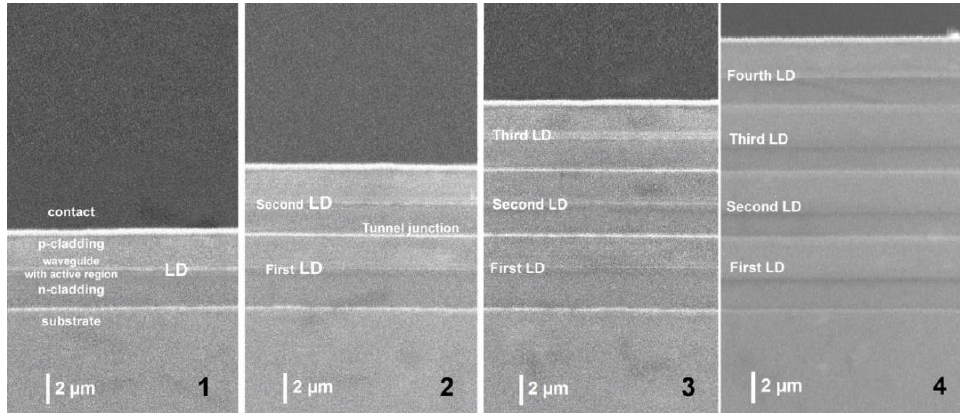
Figure 1. SEM image of single-(1), double-(2), triple-(3) and quadruple-epitaxially integrated heterostructures (4). Table 1. Dependence of the curvature radius from structure thickness and total lattice